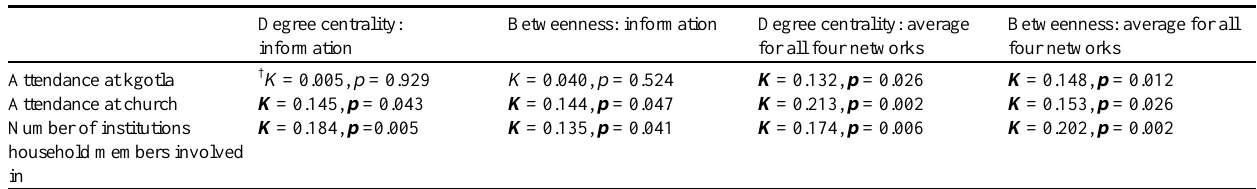
Table 3 . Nonparametric correlations between information and average degree centrality and betweenness as indicators of connectivity, and other measures of information-related social